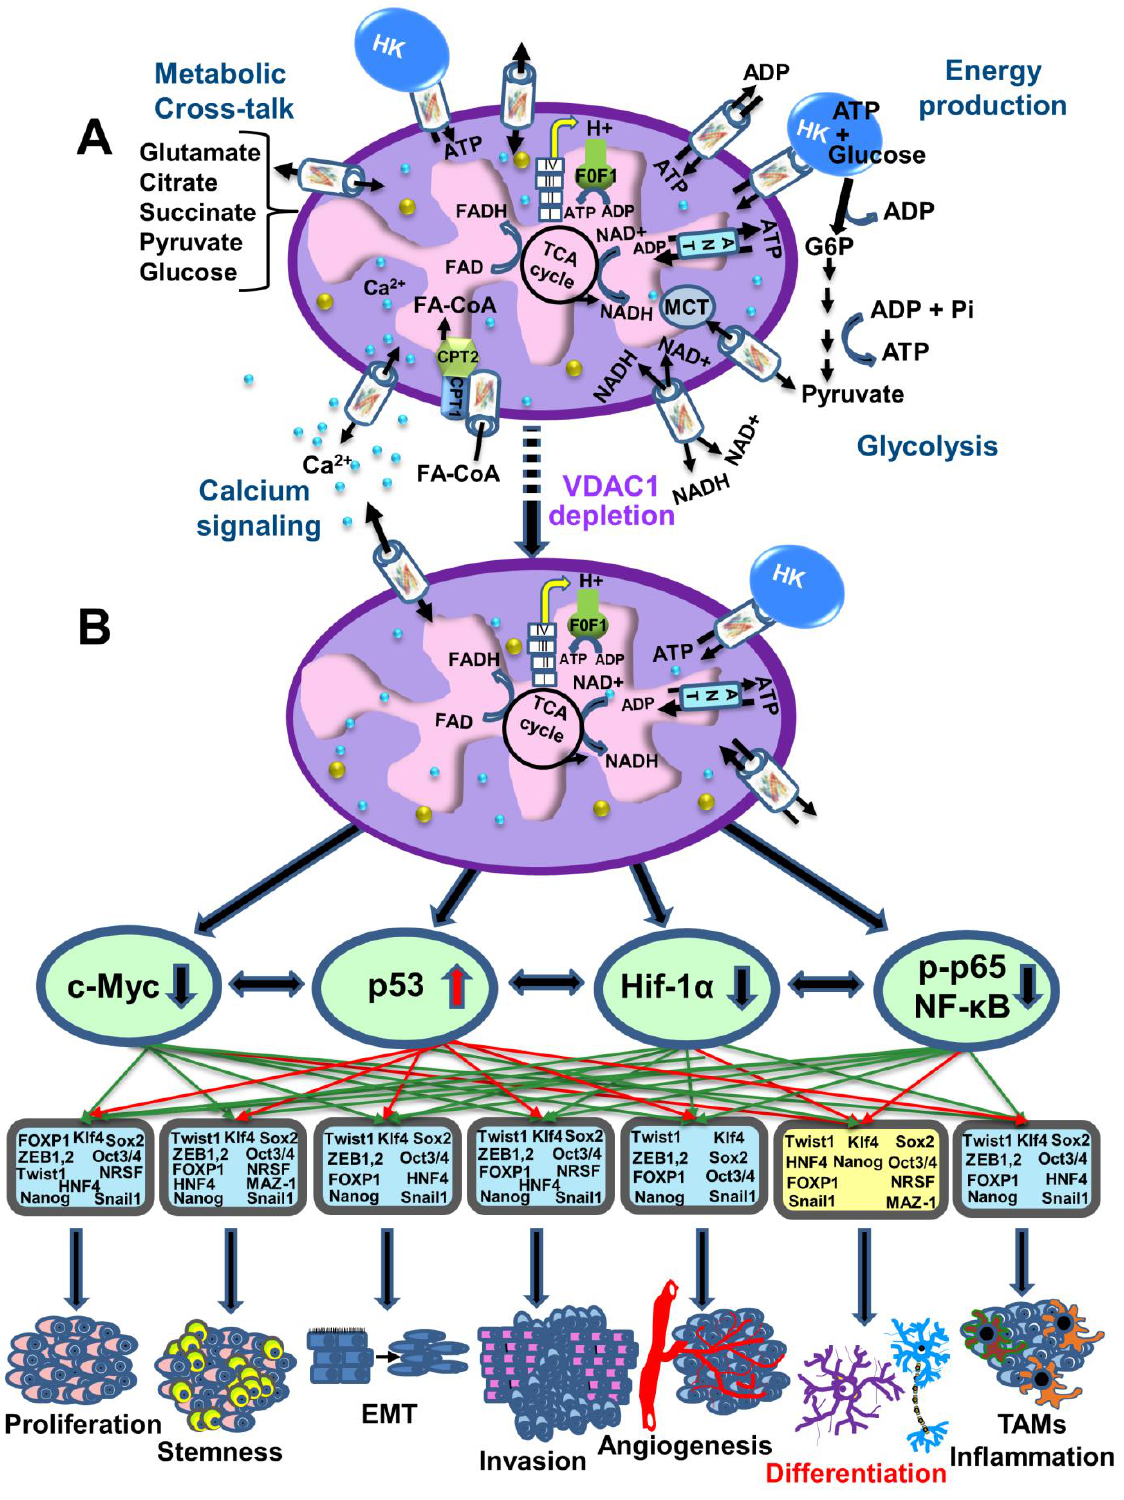
FIGURE 4: VDAC1-depletion and metabolic reprogramming leading to alterations in key transcription factor levels and biological process- es: a reversal of oncogenic properties and cell differentiation. (A) A schematic presentation of mitochondria in a cancer cell before treat- ment with hVDAC1 siRNA. Here, cancer cells maintain homeostatic energy and metabolic states, with HK bound to VDAC1 accelerating gly- colysis and mitochondrial function to allow sufficient ATP and metabolite precursor levels to support cell growth and survival. ( B) VDAC1 depletion leads to dramatic decreases in energy and metabolite generation. This leads to changes in master metabolism regulator (p53, HIF1-α, c-Myc and NF-kb, P65) expression levels, which alters the expression of transcription factors associated with stemness, EMT, cell proliferation, invasion, TAMs and angiogenesis, while leading to differentiation into astrocyte- or neuron-like